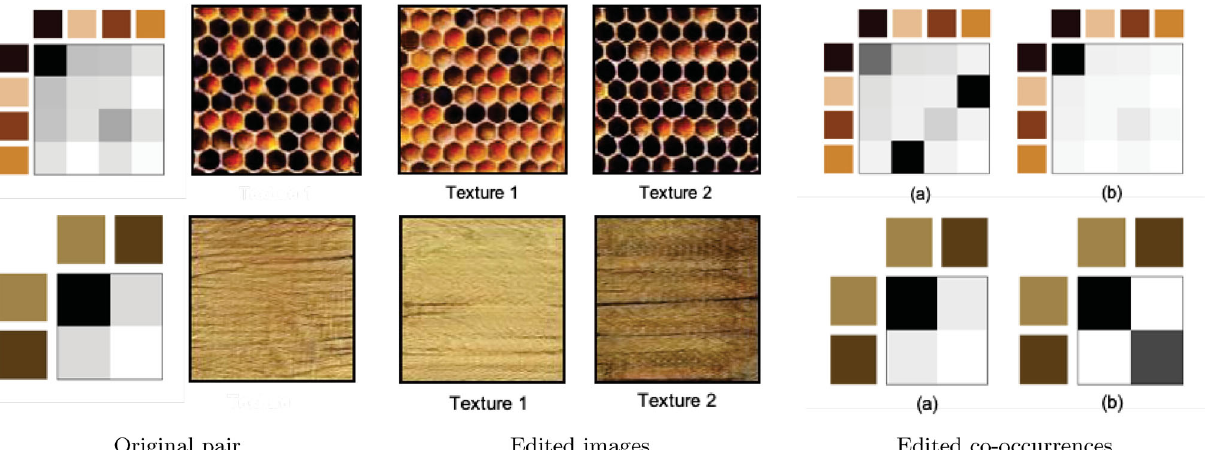
Fig. 14 User study. Given an original texture image and two different co-occurrence based edits, participants were asked to match between the edited textures (in the center) and their edited co-occurrence matrix (on the right). The correct matches are provided (cid:2) . Note that darker colors correspond to pixel values which co-occur with high probability.